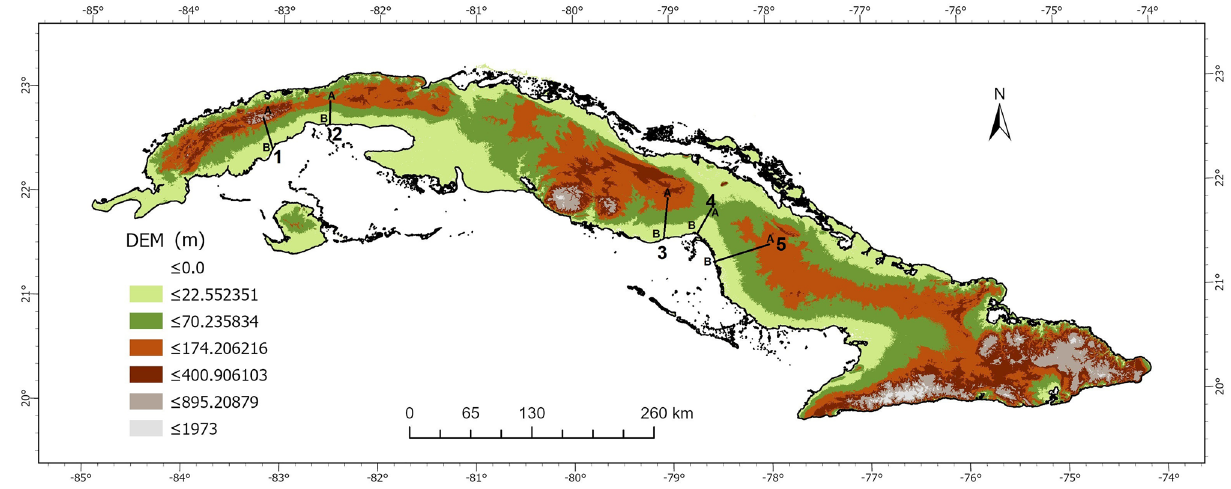
Fig. 18 Digital elevation model of Cuba